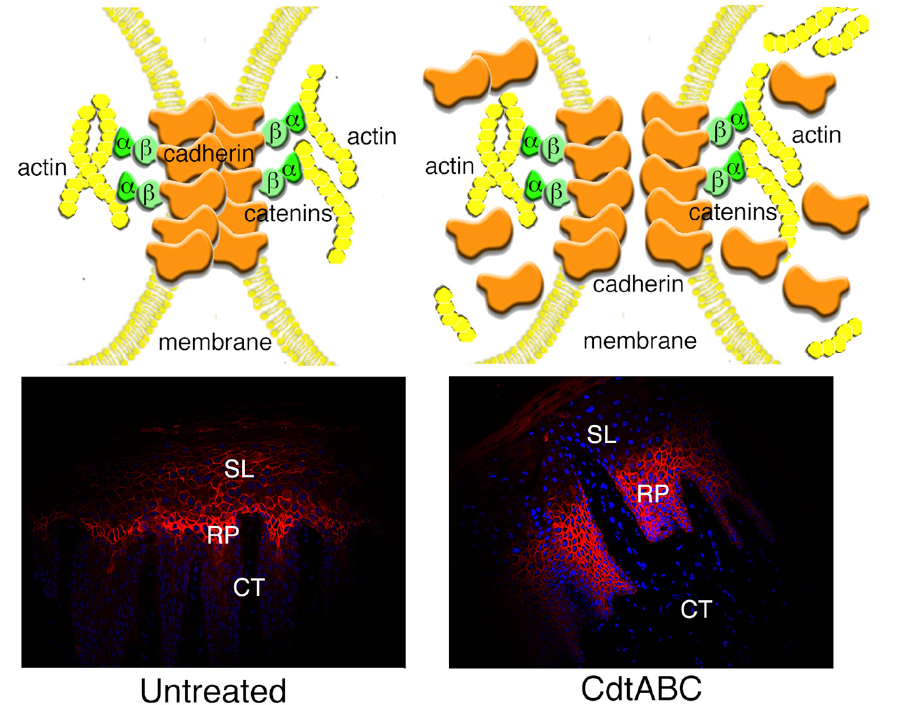
Figure 5. Model of the effects of the Aa Cdt on gingival epithelial cell adherens junctions in situ . E-cadherin was detected with a polyclonal antibody conjugated to fluorescein (red fluorescence) in untreated HGX and explants exposed to recombinant Aa Cdt. Cell nuclei were stained with DAPI (blue fluorescence). Abbreviations: SL, spinous layer; RP, rete peg; CT, connective